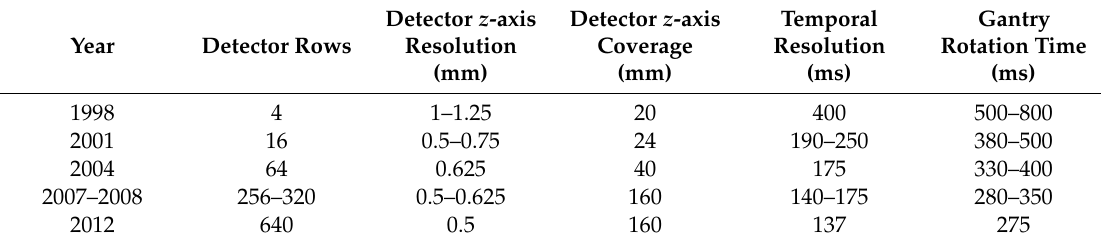
Table 1. Chronologic and technical evolution of multi-slice computed tomography (CT)